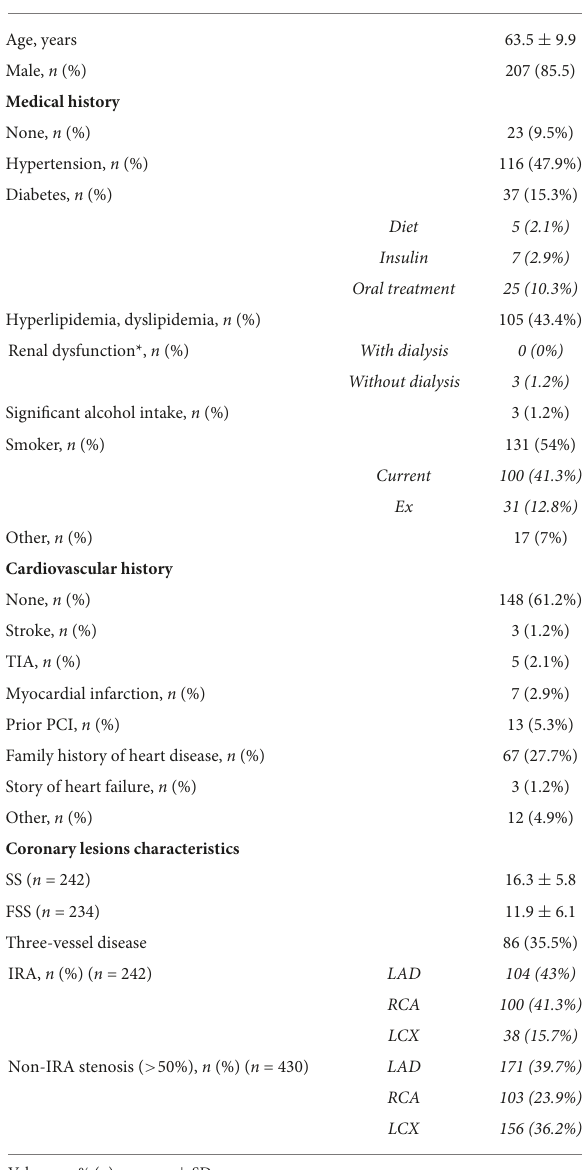
TABLE 1 Baseline patient characteristics and